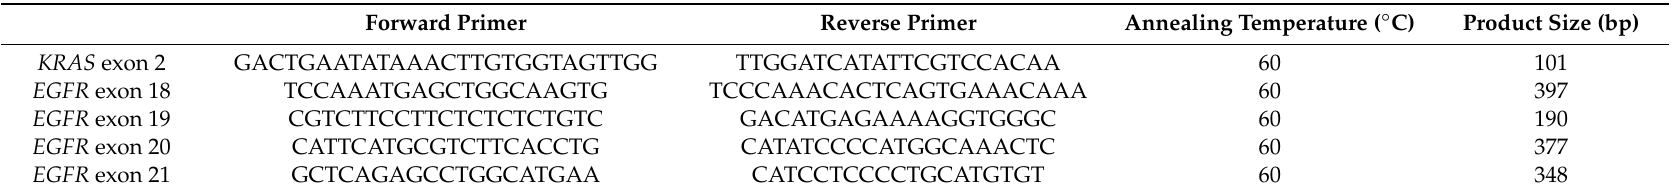
Table 2. Primer sequences.